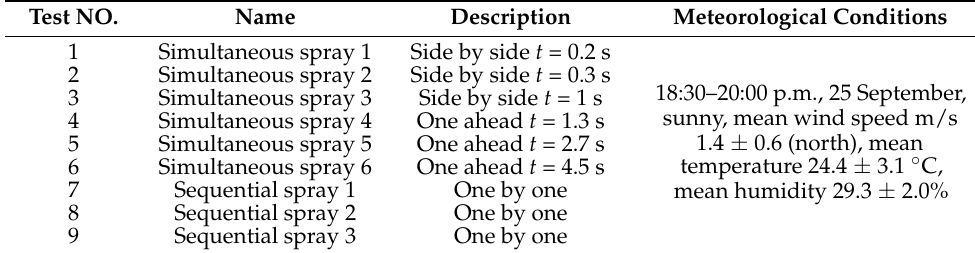
Table 1. Experimental setup and conditions of 9 tests at 3 m/s. Test NO.